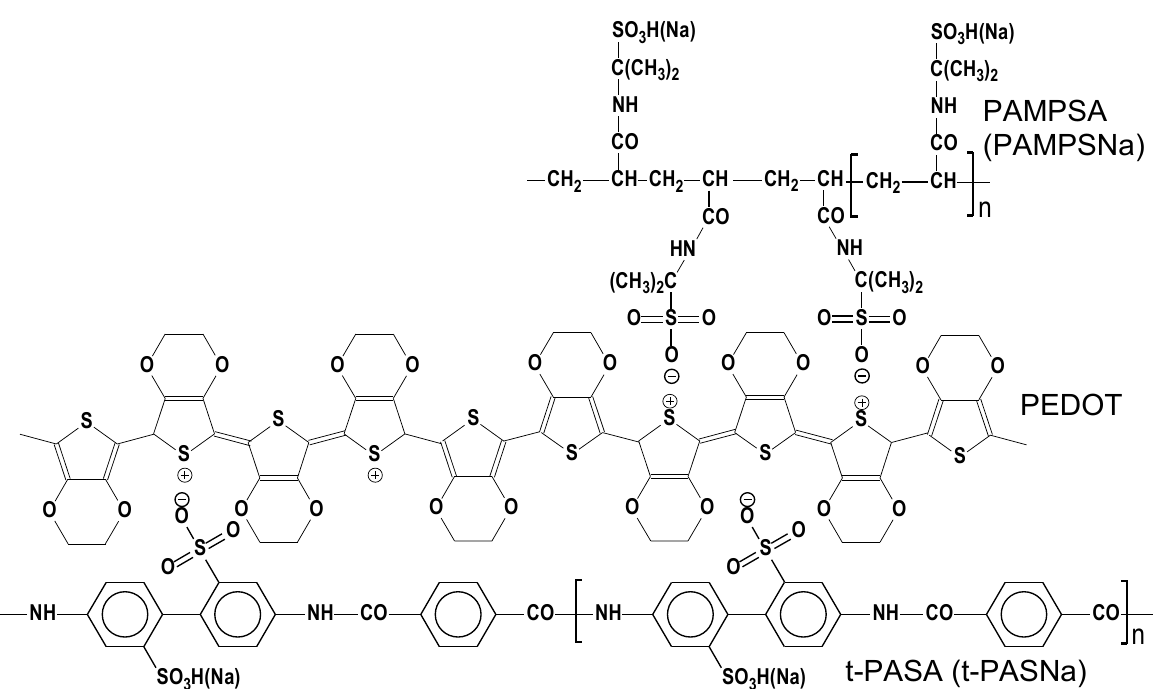
Figure 1. Structures of monomer units of polyelectrolytes used in this study (PAMPSA(Na) and t-PASA(Na)) and simplified scheme of their electrostatic interaction with charged PEDOT moieties (scheme of bipolaron is based on [35]).